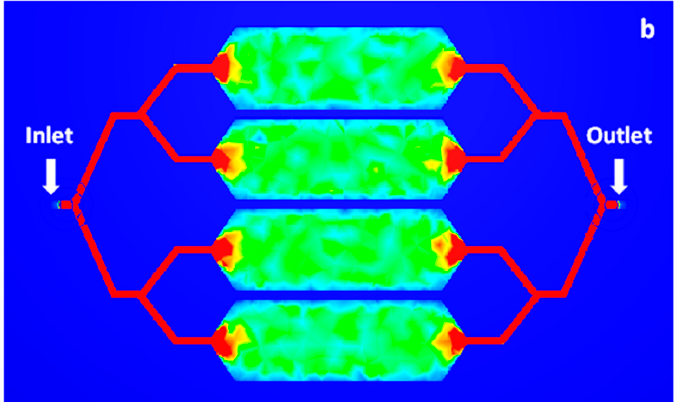
Figure 2. Velocity amplitude of a 3 cm long and 4 cm wide buffer tank ( a ) and of a set of 4 buffer tanks in parallel of 3 cm long and 1 cm wide each ( b ). The depth is fixed to 0.1 cm, the flow rate at the inlet is set to 5 NmL·min − 1 and the pressure at the outlet is maintained at atmospheric pressure. The velocity scale is in cm·s − 1 and is the same for insets. In red are represented areas with a velocity superior or equal to 0.5 cm·s − 1 . Both chips are 86 cm long and 49 cm wide. These simulations were performed using the Autodesk CFD (Computational Fluid Dynamics) software.